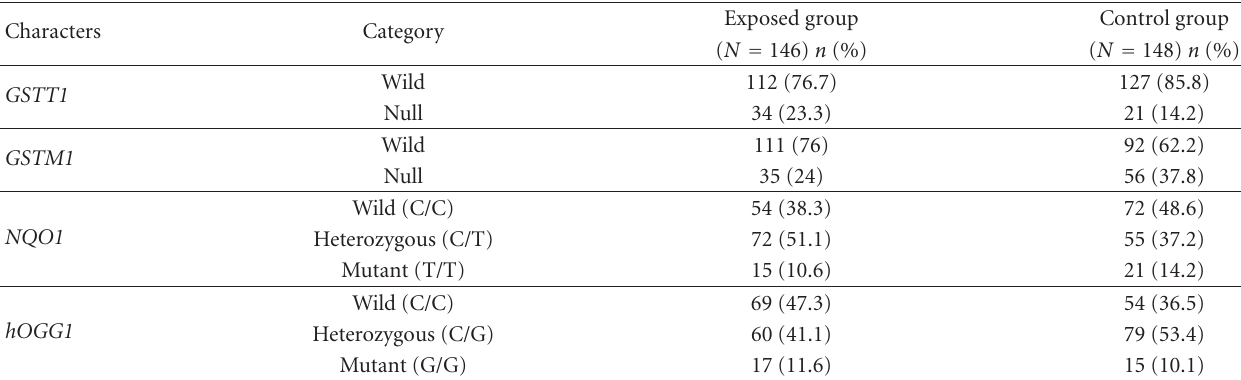
Table 3: Genotypic distribution for GSTT1 , GSTM1 , NQO1 C609T, and hOGG1 C1245G genes among exposed and control group.